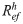
Estimation of Model FD in Period 2 (October/2000—September/2004).(a) observed incidence (O) and adjusted i (E), (b) m3/m, (c) Refh (h) and Refm (m), and (d) Ref=Refh×Refm.